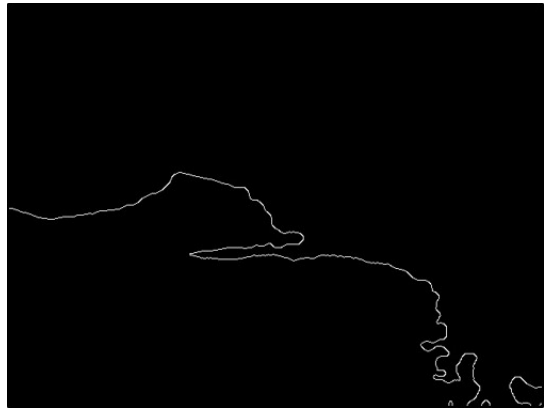
Figure 23. Image using canny edge detector.